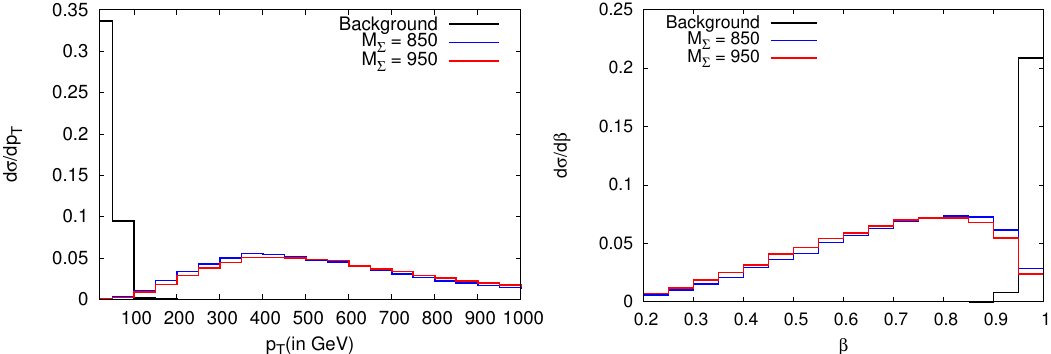
Figure 4 . p T -and (cid:12) -distribution of the opposite sign stable charged tracks of (cid:17) (cid:6) seesaw with sterile neutrino for the benchmark points BP1 (blue) and BP2 (red) as in table 2. Background muon distribution is shown in black